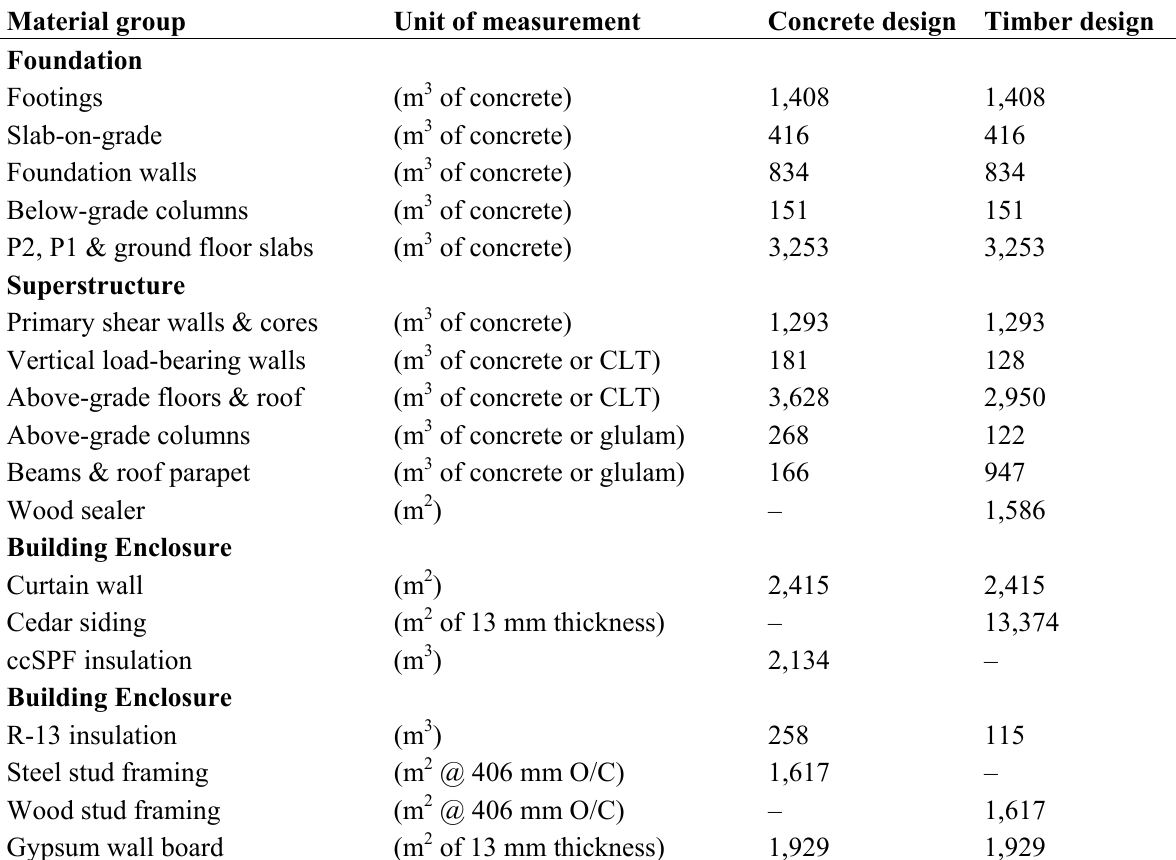
Table 3. Material quantities comparison (based on a 50-year building